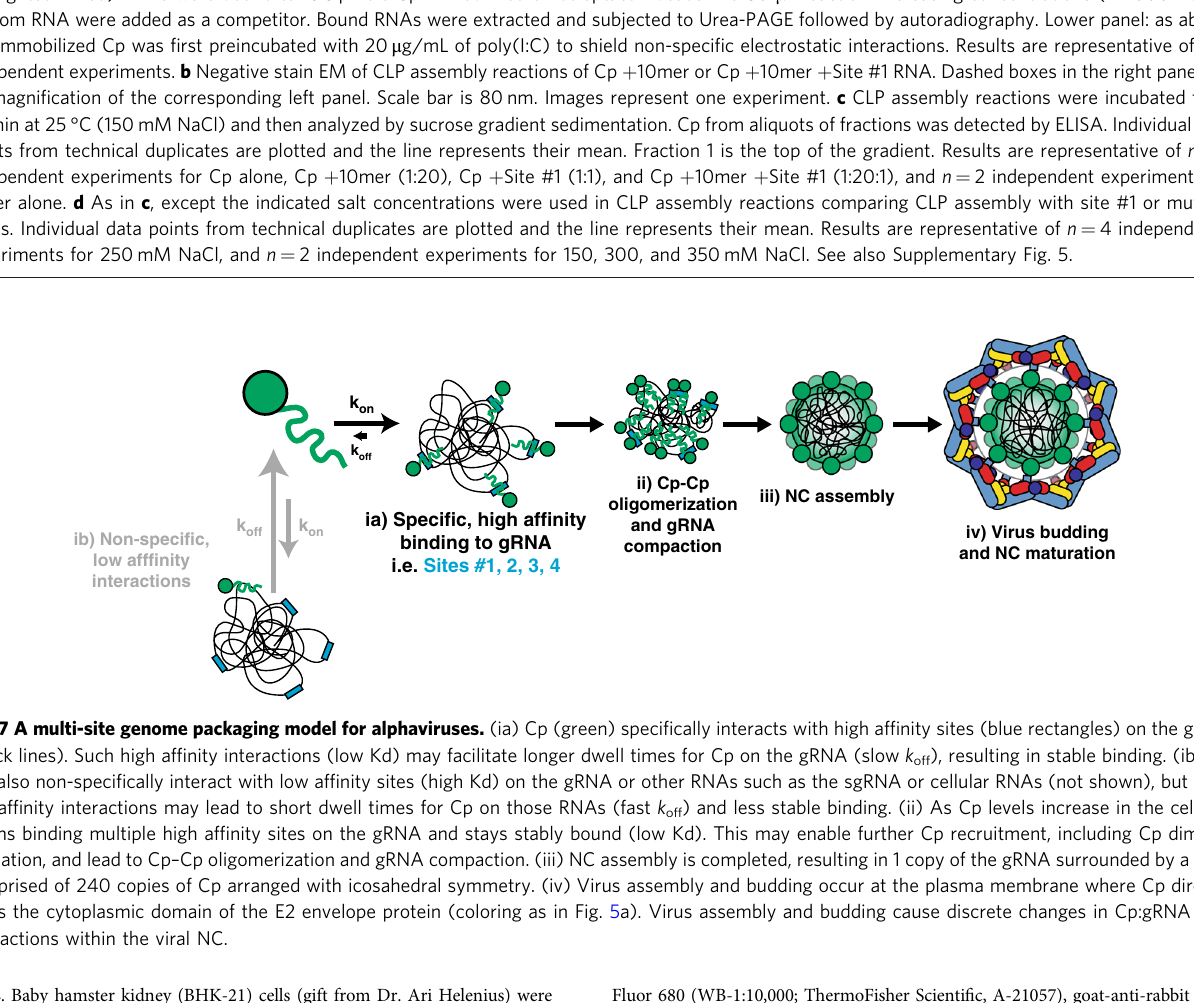
expressing HA-BirA were generated by transfecting cells with the expression plasmid described below using Lipofectamine 2000 (Invitrogen). 48h post-trans- fection, cells were split to 25% con fl uency and selected with 1mg G418/mL (Sigma- Aldrich) for 2 weeks. G418-resistant cells were then seeded sparsely and individual clones isolated using cloning cylinders (Corning). Clones were screened for their ability to biotinylate Cp-mAVI by western blot and fl uorescence microscopy using streptavidin probes. Cell lines were authenticated by morphologic evaluation and were checked for mycoplasma contamination (MycoAlert TM PLUS Mycoplasma Detection Kit, Lonza).